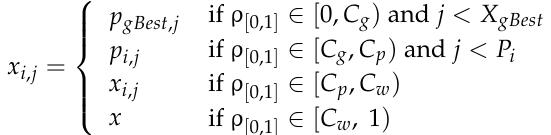
Table 11. The example of the update in the proposed fuzzy simplified swarm optimization (fSSO). CoordinateLength of X 5 1 2 3 4 5 Old X 5 2 4 P 5 1 G 2 ρ 0.34 Note that the numbers marked with “*”are generated